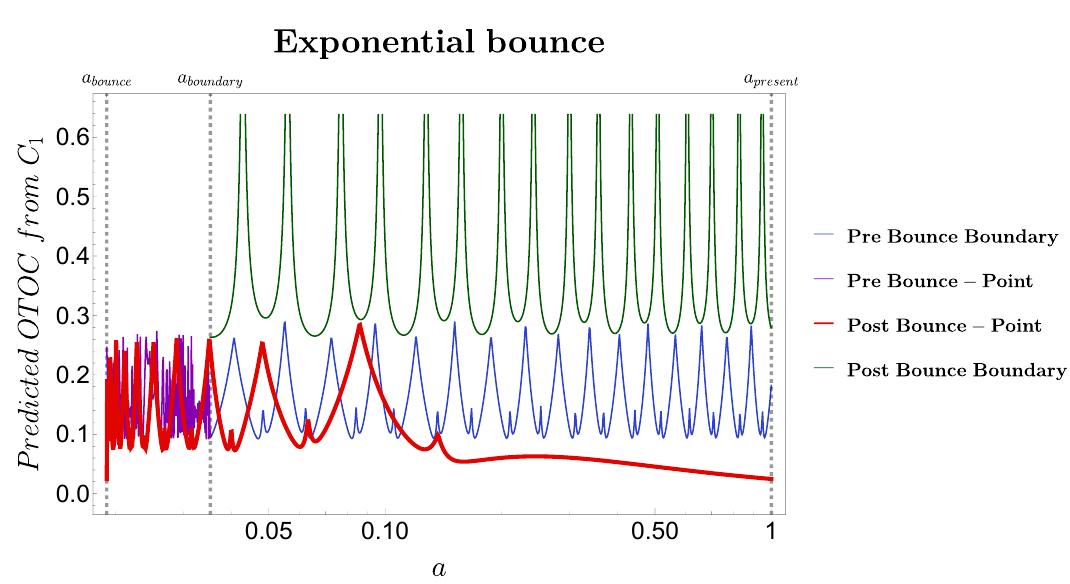
Figure 33: Predicted OTOC from linearly weighted complexity in different regions against scale factor.